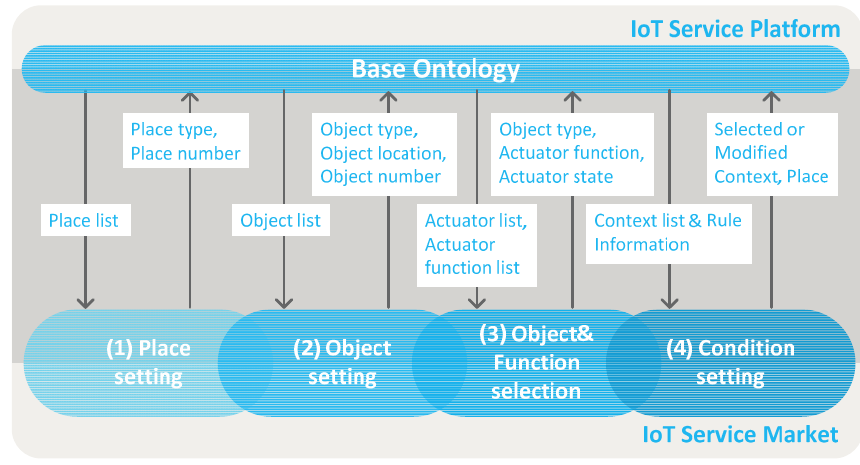
Figure 4. User-driven service modeling